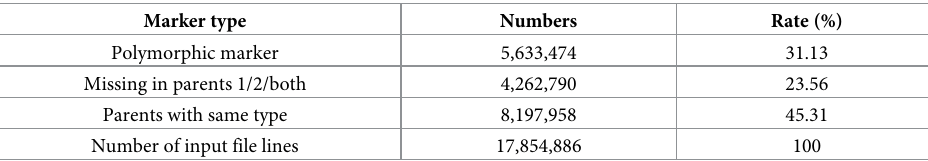
Table 2. Polymorphism locus